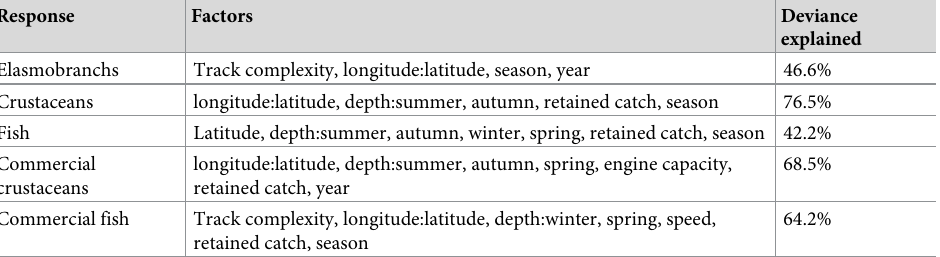
Table 3. Generalised additive mixed model results for species groups relationship with environmental and opera- tional factors (the discard drivers), shown are final reduced models (i.e. only statistically significant factors).